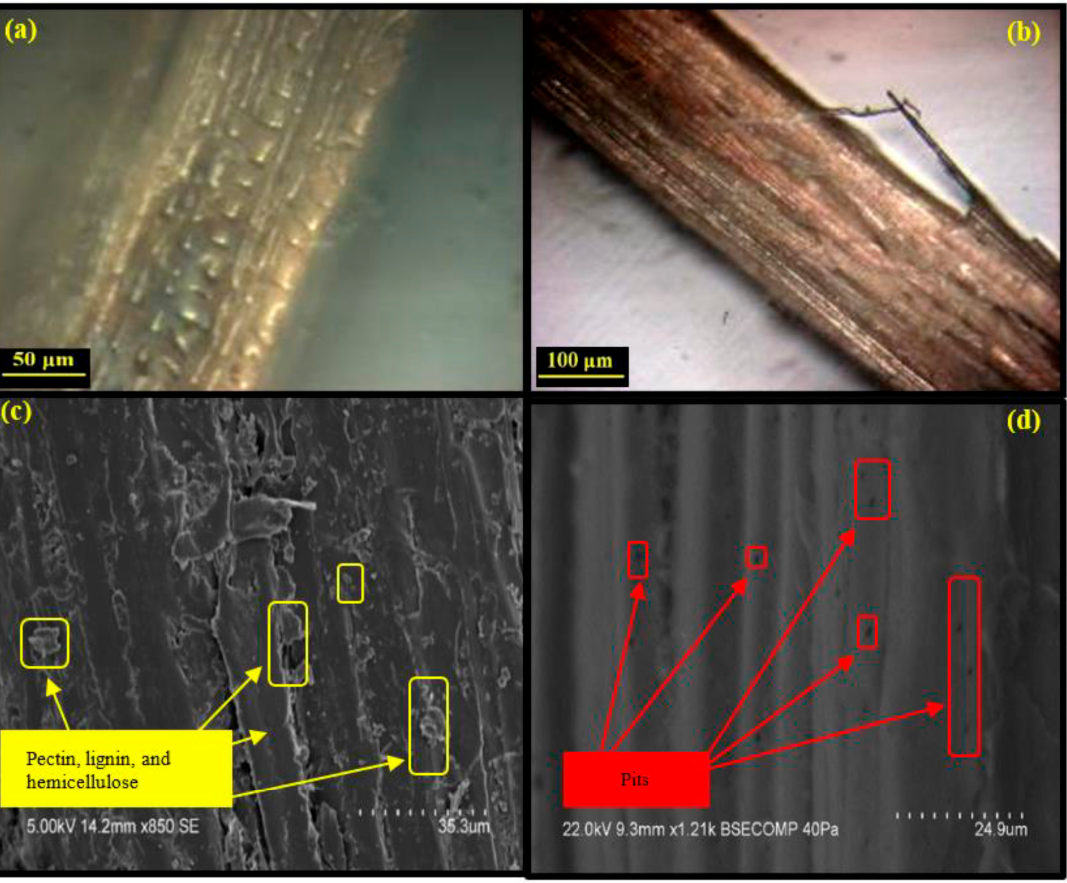
Figure 3. SEM images of PS fibers, including ( a ) rough surface of the fiber; ( b ) longitudinal section of unit fibers; ( c ) presence of lignin, pectin, and hemicellulose particles; ( d ) presence of cavities on the surface of the